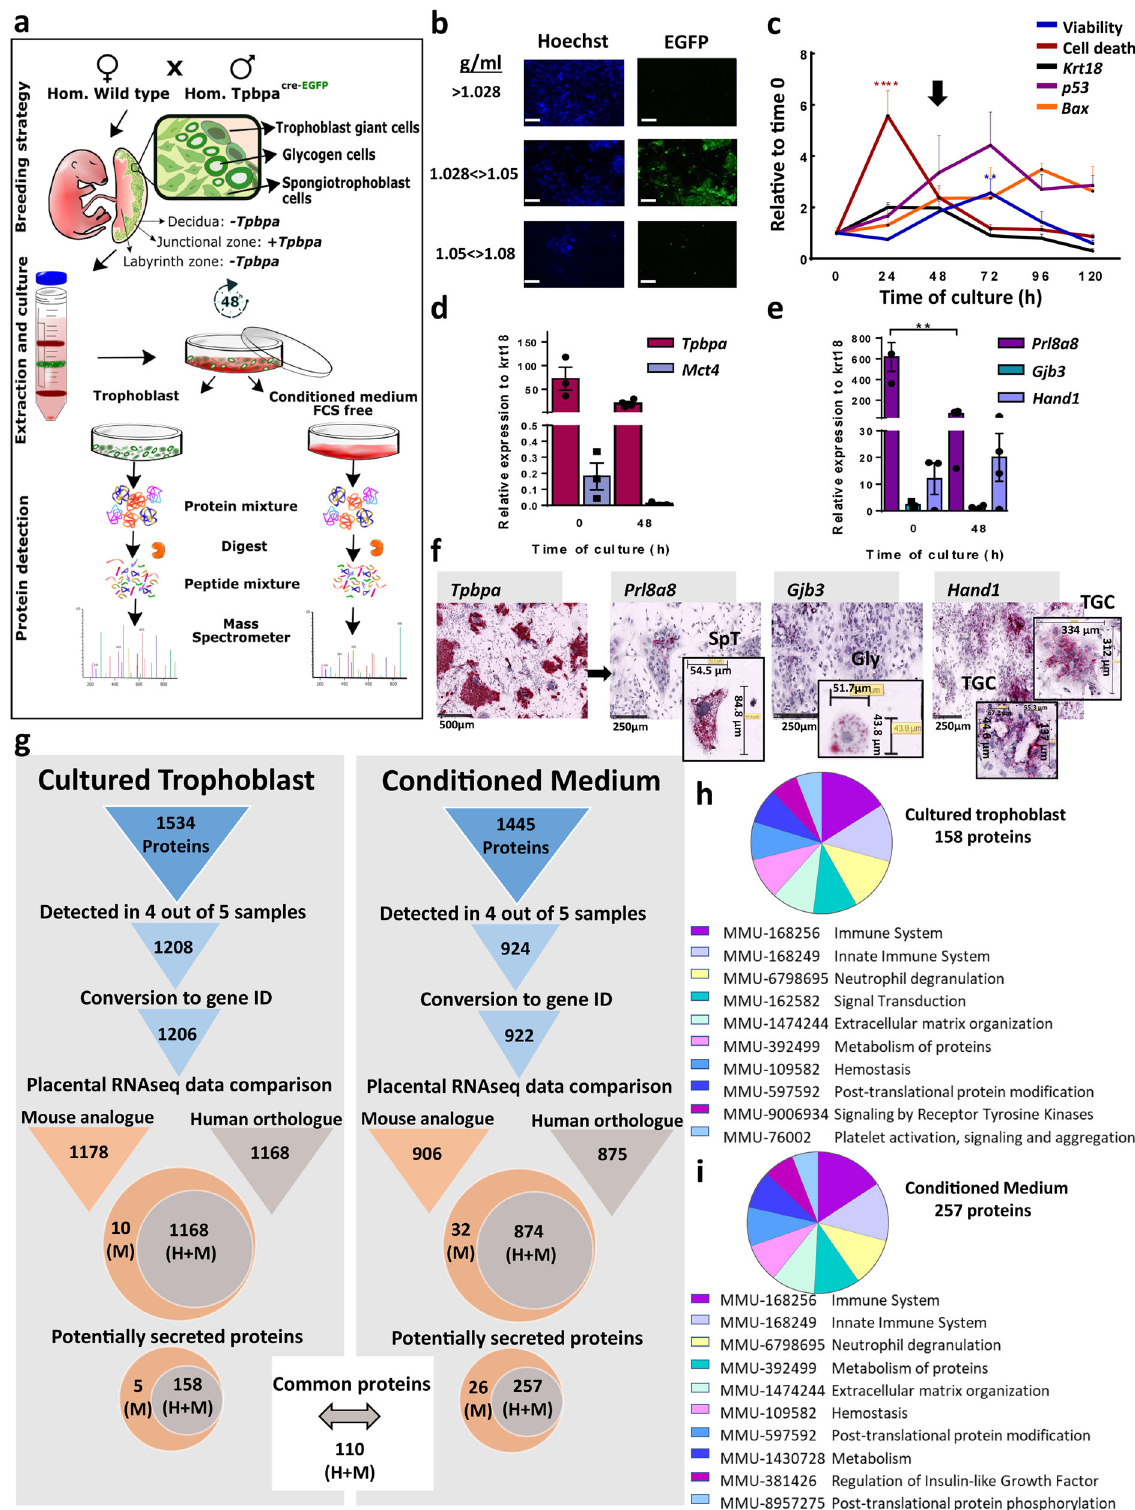
harvested placentas at day 16 of gestation from wild-type females mated with males expressing Cre-EGFP under the Tpbpa pro- moter, which is speci fi cally active in the trophoblast endocrine cells of the junctional zone 13 (Fig. 1a). Day 16 of gestation was chosen as this corresponds to when all the endocrine cells in the mouse placenta have differentiated and are